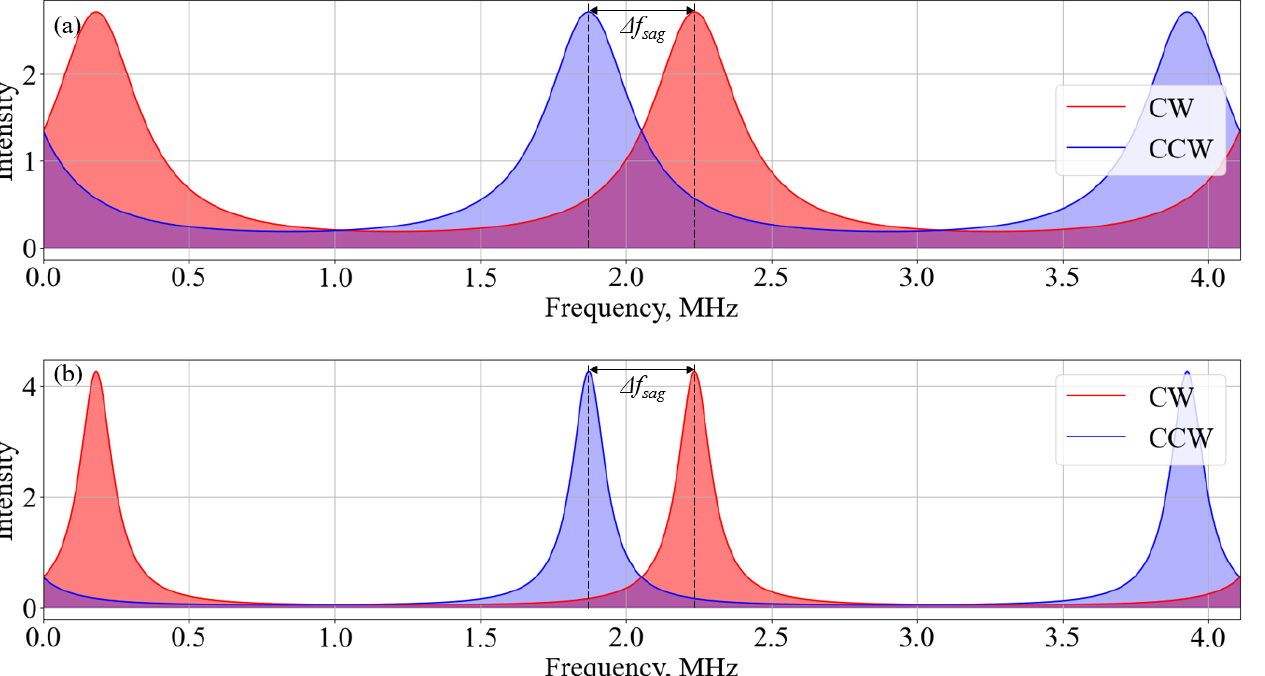
Table 2. Parameters of the FORR on a single-mode